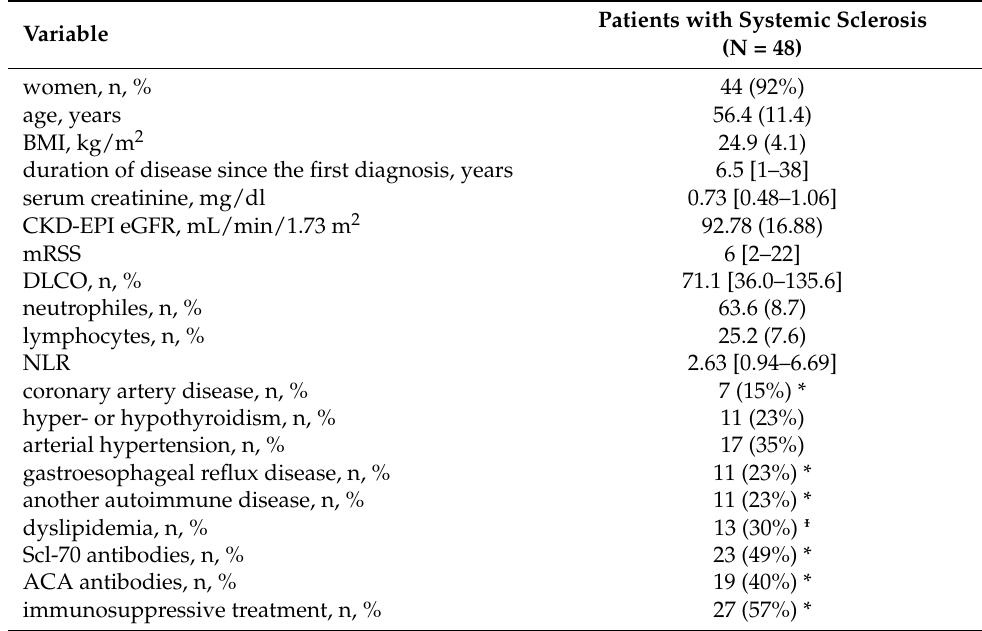
Table 1. Demographic, clinical, and laboratory results of patients in the experimental group.